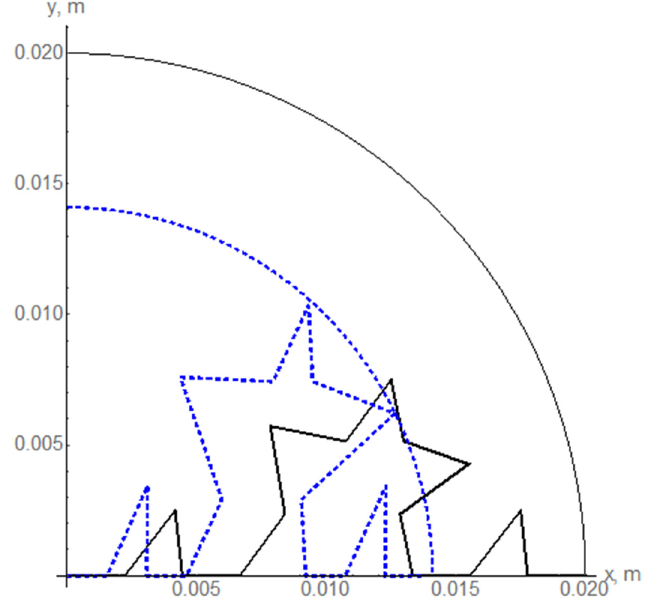
Figure 9. The arms and envelopes of the designed antennas. The blue color corresponds to the smallest antenna with S 11 = − 7 dB (radius is 14.1 mm), while the black color corresponds to the miniature antenna with S 11 = − 15 dB (radius is 20 mm).